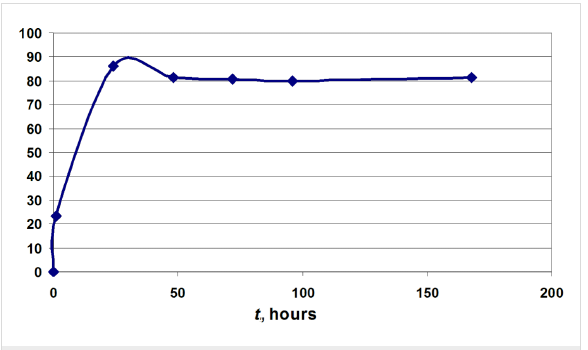
Figure 5: Clofarabine content in the reaction mixture vs time (hours) of the reaction.